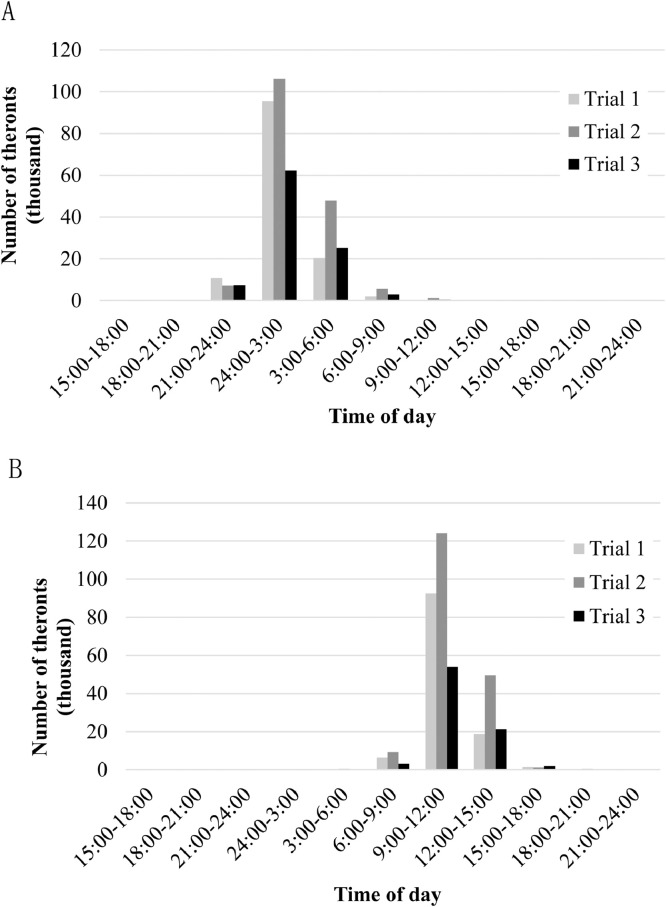
Time of day for theronts to excyst from tomonts obtained from five infected fish. A: Tomonts were incubated under a photoperiod of 6:00–18:00 Light and 18:00–6:00 Dark. B: Tomonts were incubated under a photoperiod of 15:00–3:00 Light and 3:00–15:00 Dark.